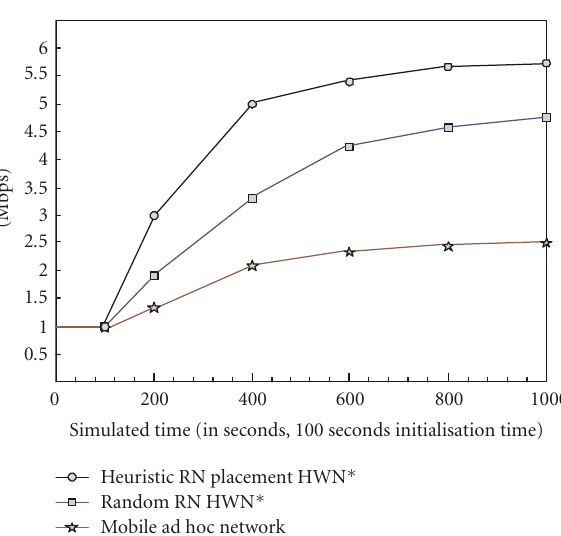
Figure 8: Average capacity comparison of heuristic RN HWN ∗ , random RN HWN ∗ , and mobile ad hoc network.